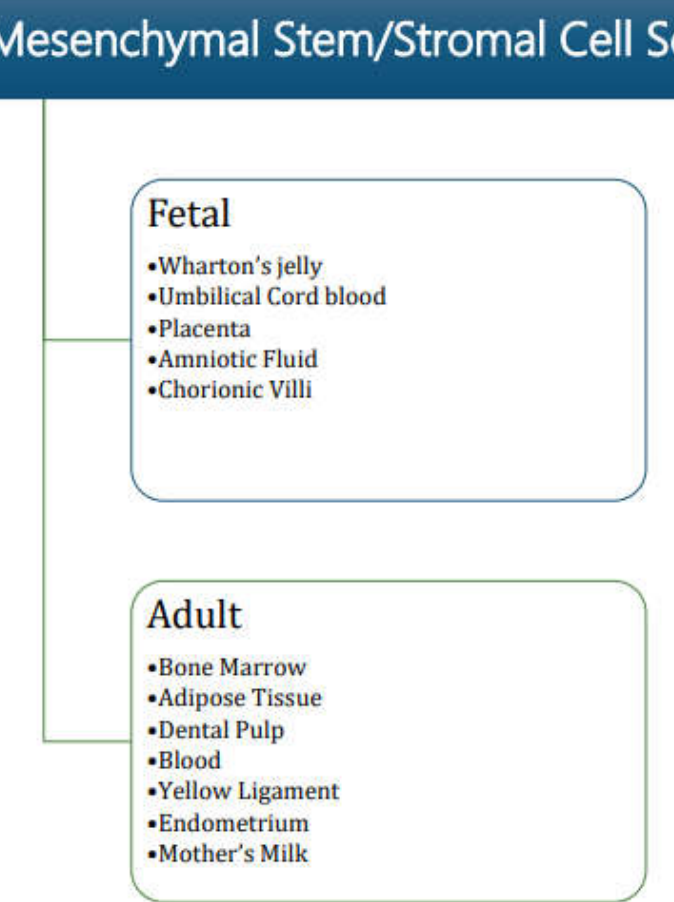
Figure 1. Sources of mesenchymal stromal/stem cells.